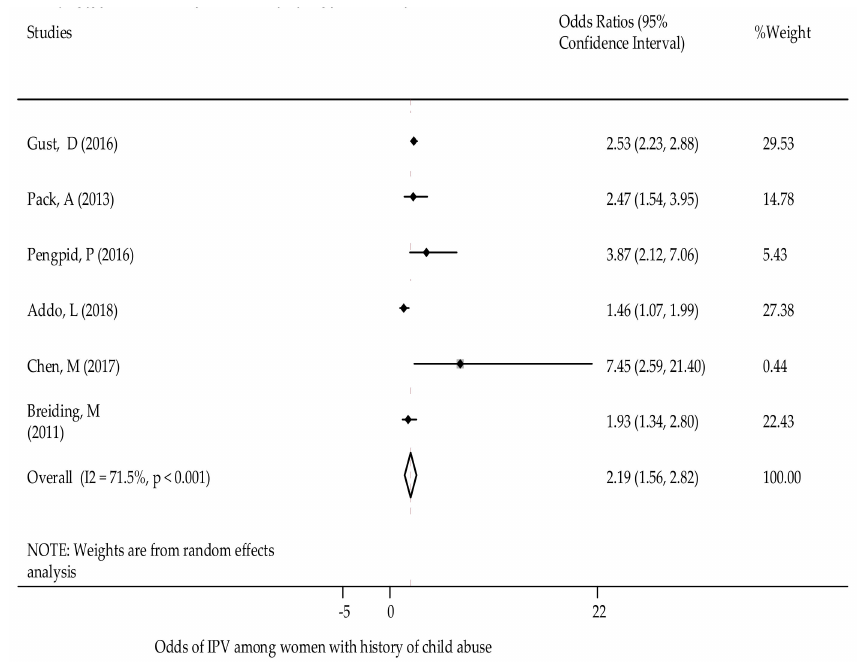
Figure 7. The association of history of child abuse and GBV